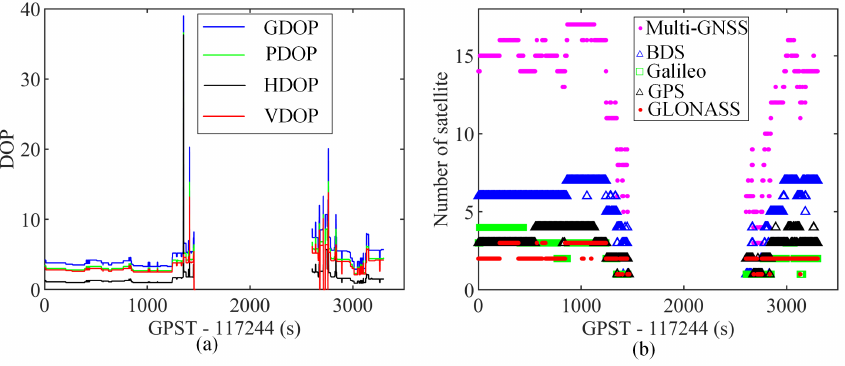
Figure 7. Number of available satellites and DOP for the multi-GNSS scenario with a 35 ◦ cut-off elevation angle. ( a ) Number of satellites. ( b )